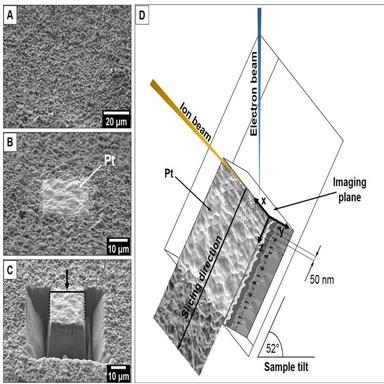
(A) SEM-SE image of an oxide scale formed on the 718Plus superalloy after 120 h of oxidation in air at 850 °C (tilted sample); (B) selected area coated with platinum (SEM-SE); (C) SEM-SE image of the sample before serial sectioning (slice-and-view technique); (D) Scheme of the sample cube geometry optimized for FIB serial sectioning procedure.